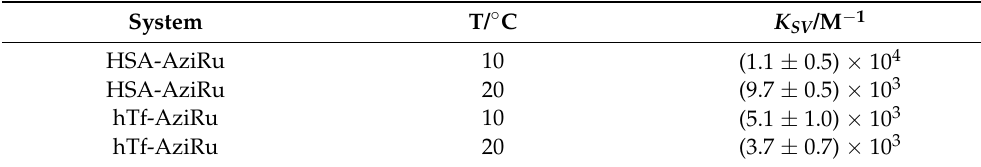
Table 1. Stern–Volmer constants for the complex formation between AziRu and serum proteins obtained at 10 ◦ C and 20 ◦